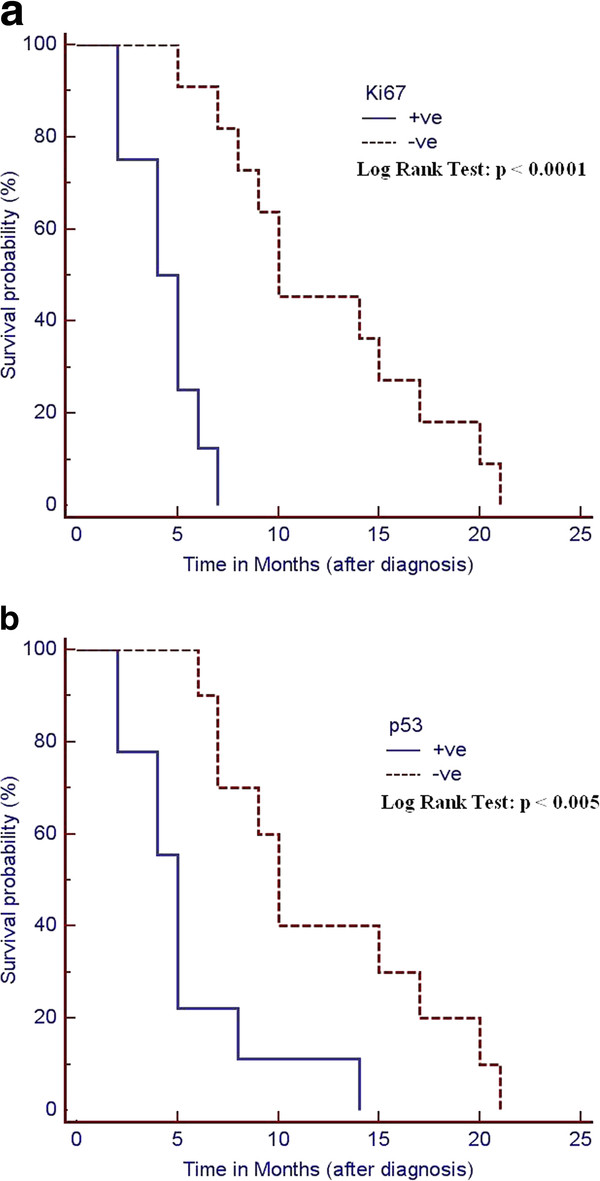
a: Overall-survival of all patients included in the study, with p53 immunohistochemicalresults. b: Overall-survival of all patients included in the study, with Ki67 immunohistochemical results.